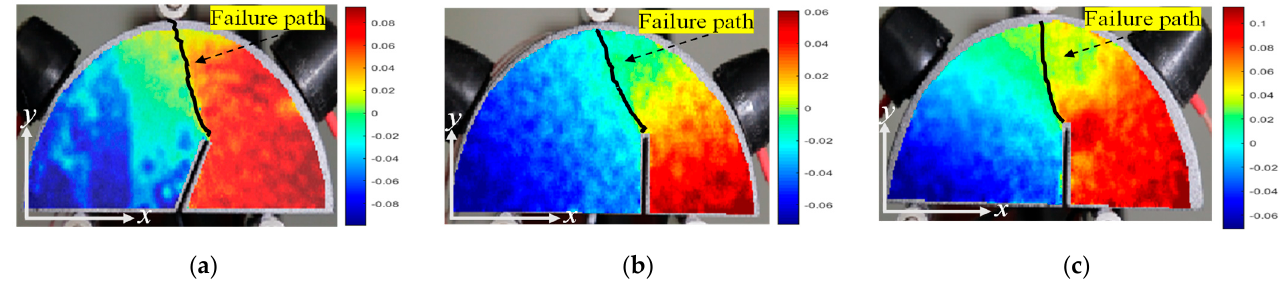
Figure 7. x-displacements and the failure paths of specimen failure: ( a ) ANSCB − I; ( b ) ANSCB − II; ( c ) ANSCB − III.